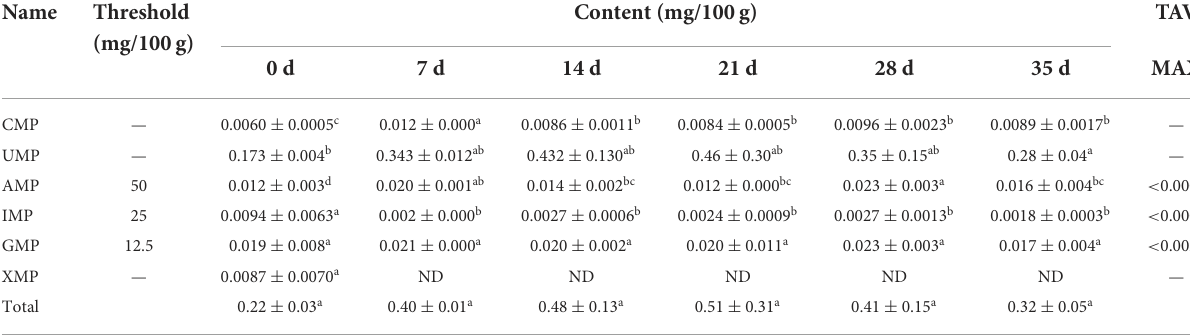
TABLE 1 The changes of nucleotide contents in preserved egg yolk during